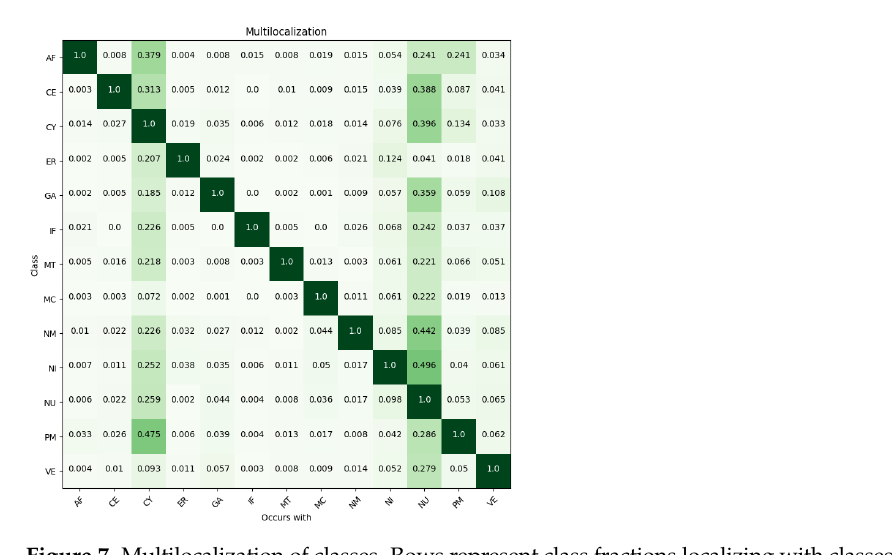
Figure 7. Multilocalization of classes. Rows represent class fractions localizing with classes in columns. Darkness (value) of color represents fraction value; higher fractions are depicted with darker color.